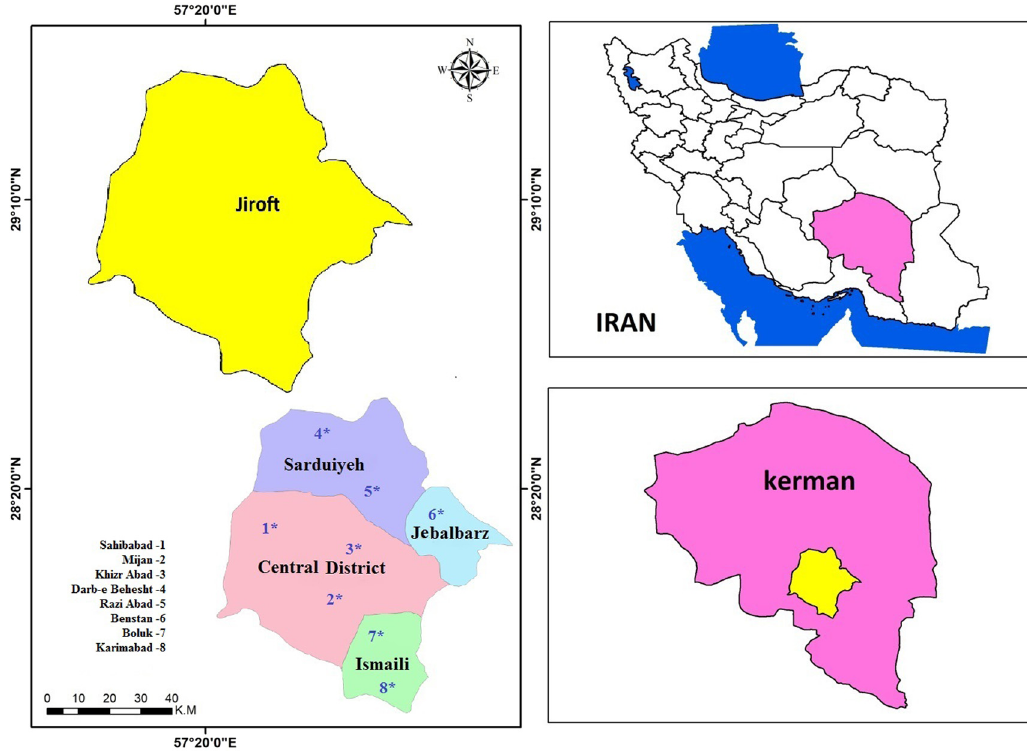
Figure 2: Geographical location of